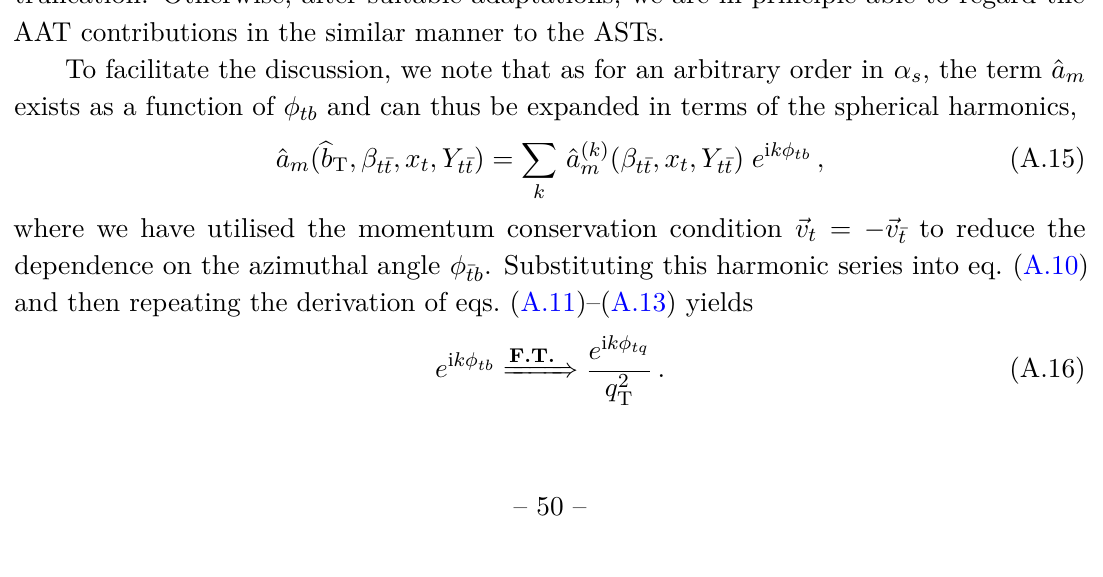
Figure 12 . Comparison of the q T -weighted NLO double differential spectra q T d σ shown as distributions of q T in slices of ∆Φ tX . Herein, NLO represents the QCD result calculated in S HERPA [169–171]. NLO s labels the azimuthally symmetric and NLO s+a marks the full, i.e. azimuthally symmetric and asymmetric , contributions derived from SCET II + HQET,